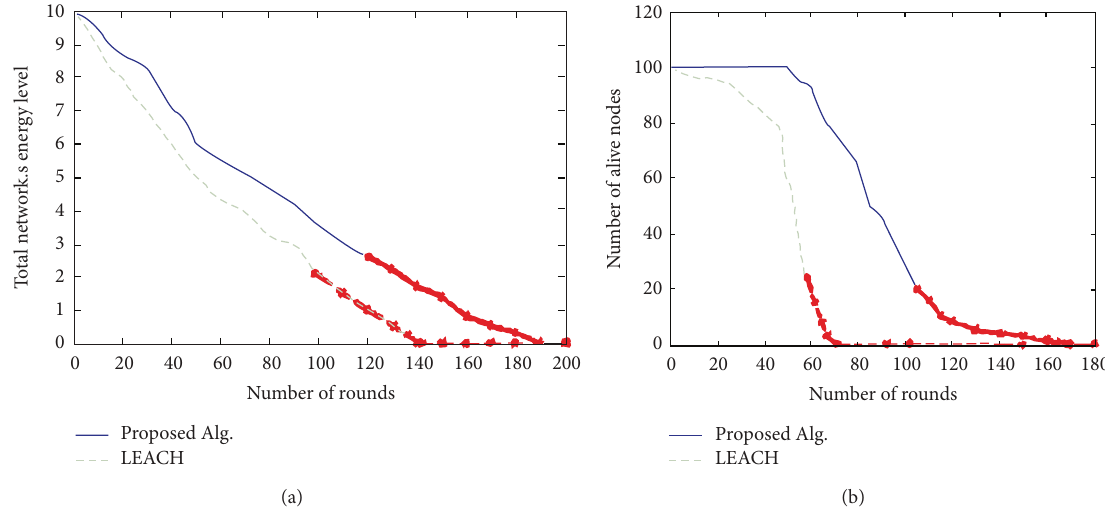
Figure 6: (a) Energy consumption rate in lifetime of virtual environments. (b) Comparison of coverage in two